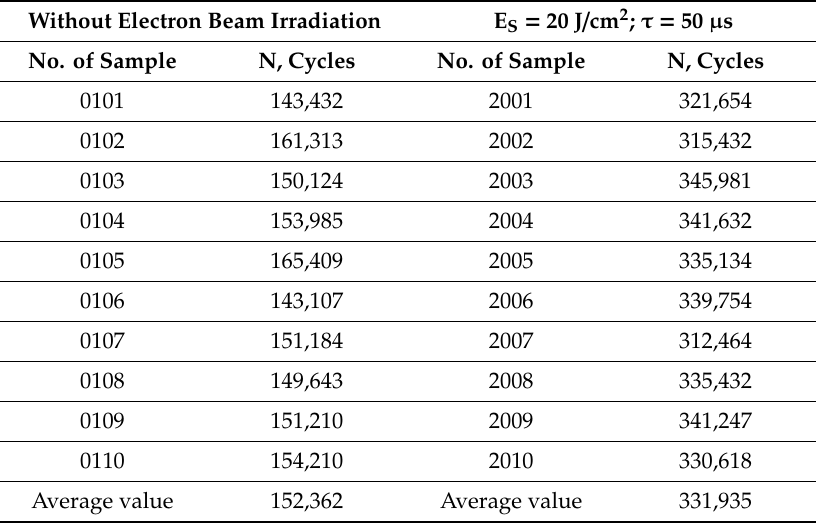
Table 2. Results of fatigue texts of AISI 310S steel.